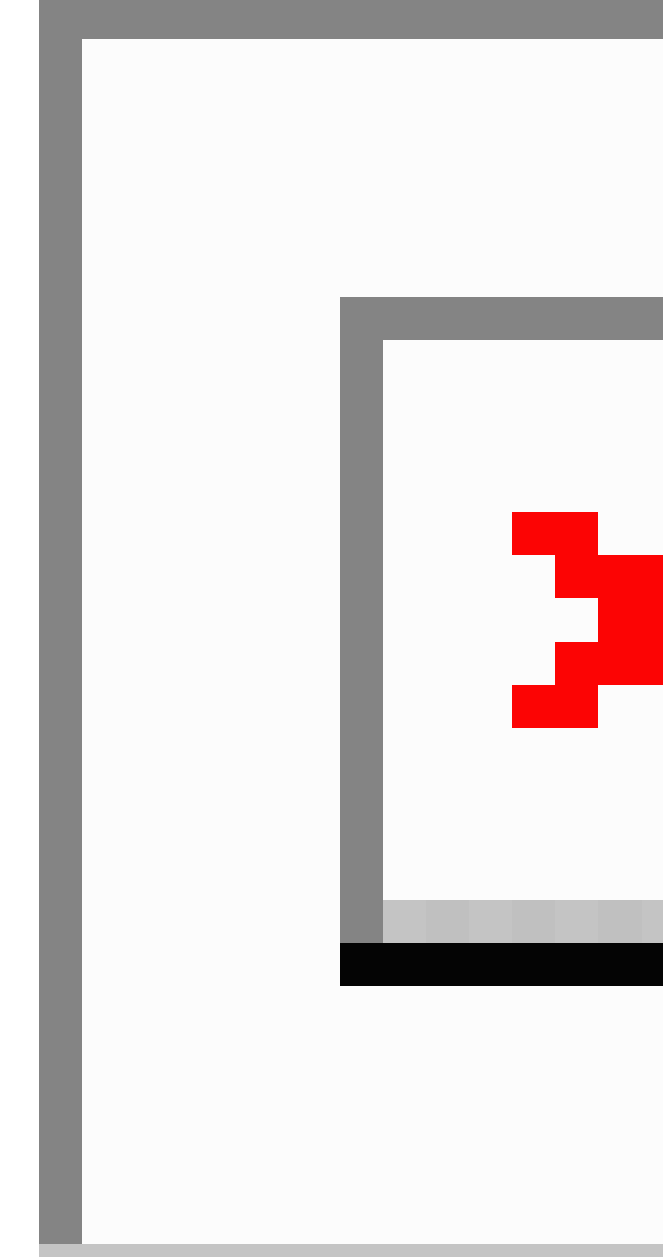
Figure 2. Task flow for a user in the tag-based interface